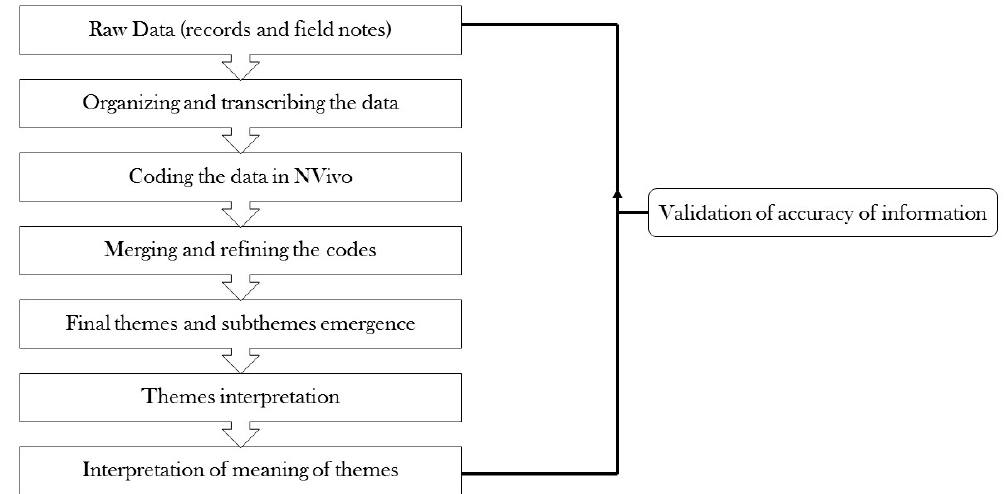
Figure 1. Steps used in qualitative analysis.